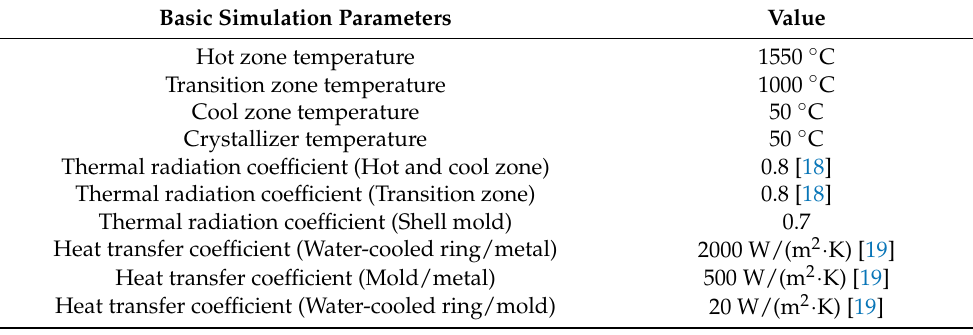
Table 4. Basic parameter setting of ProCAST numerical simulation.